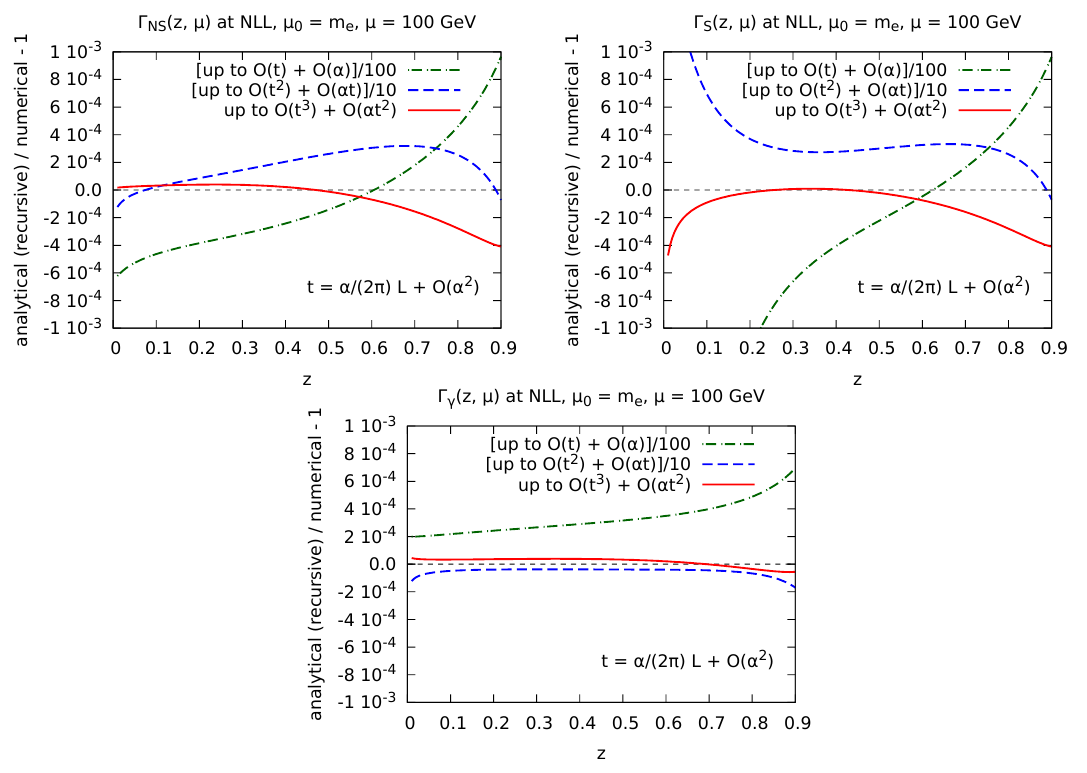
Figure 13 . Agreement between recursive solutions of various accuracies, and the numerical pre- dictions, for the non-singlet (top left panel), singlet (top right panel), and photon (bottom panel), for (cid:22) = 100 GeV. See the text for